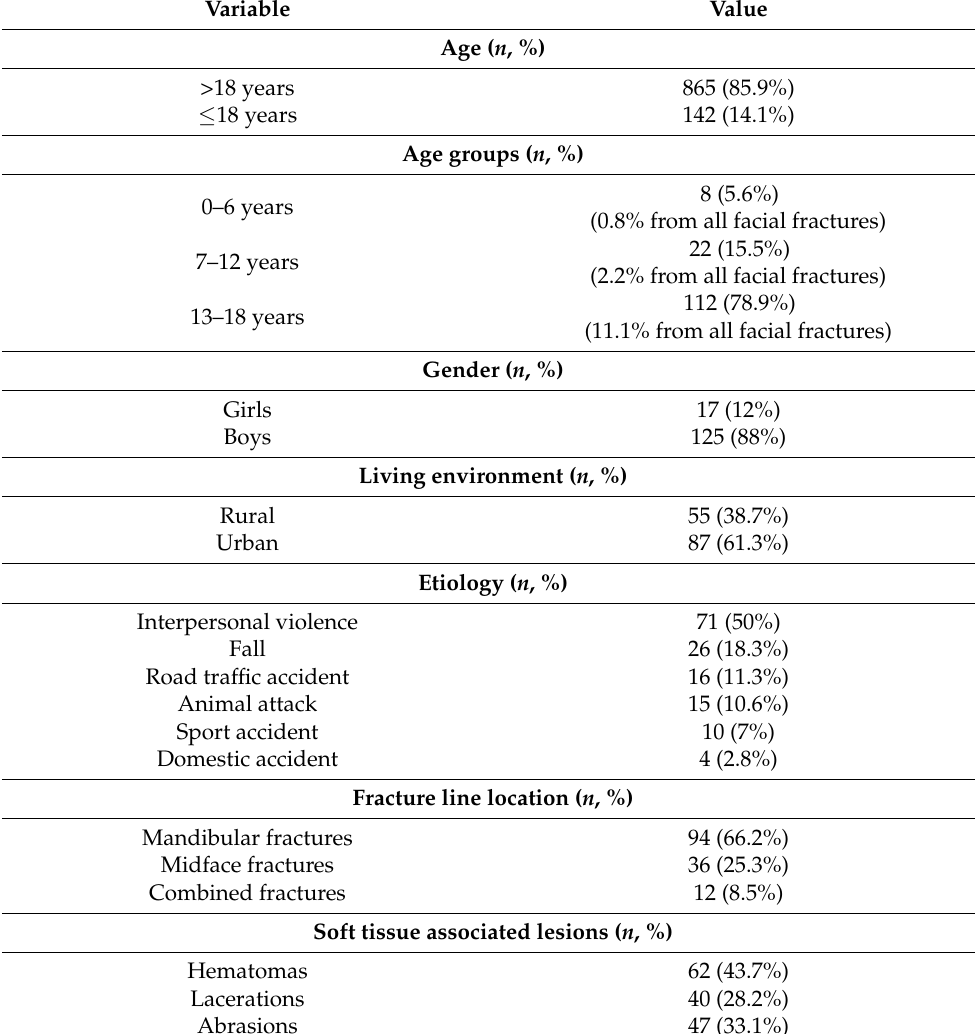
Table 1. Distribution of the patients according to the various